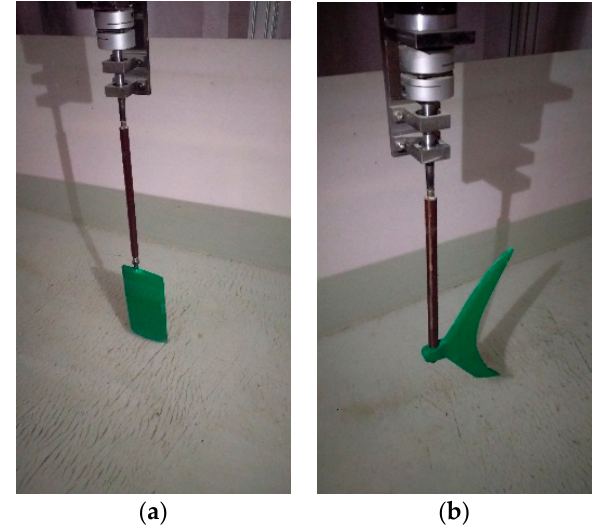
Figure 16. Installation photo of the bionic foils: ( a ) NACA foil; ( b ) crescent-shaped foil.